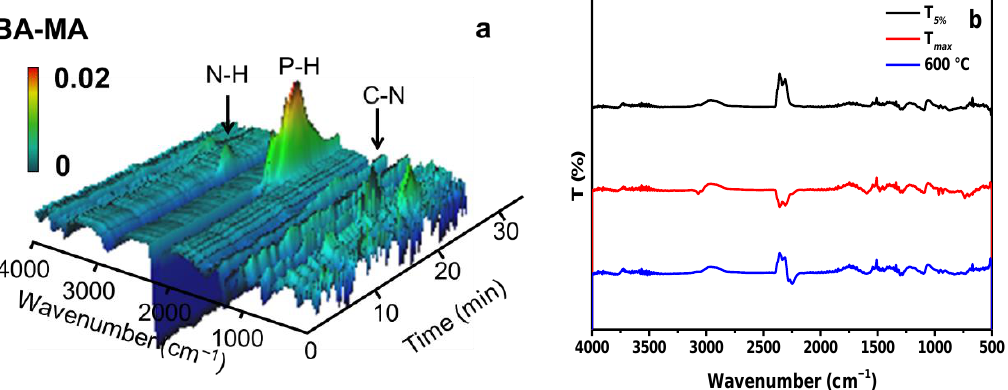
Figure 10. FTIR 3D map of evolved products at various times ( a ) and typical FTIR spectra at different temperatures ( b ) during the thermal degradation of BA-MA.